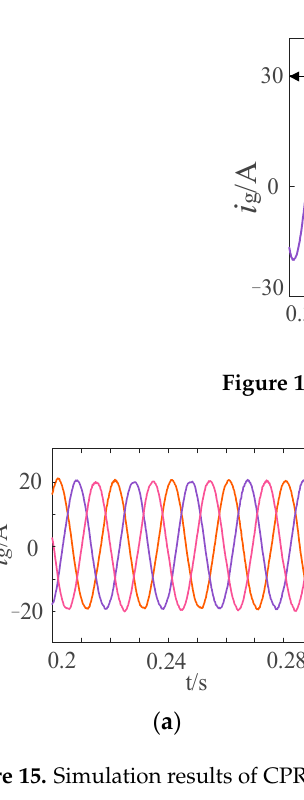
Figure 13. Steady ‐ state responses when Lg is 5 mH.